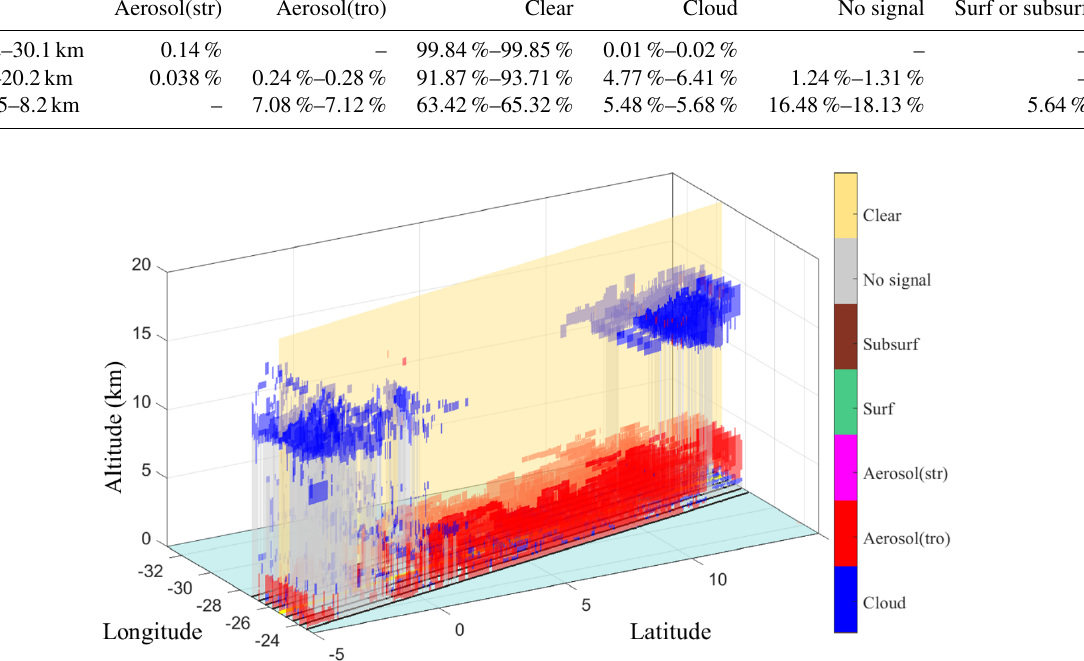
Figure 2. Demonstration of the expansion of the active–passive retrieved cross section (RXS), which runs through the center, for a transect near African Atlantic coast between 15 ◦ N and 5 ◦ S on 23 April 2015.